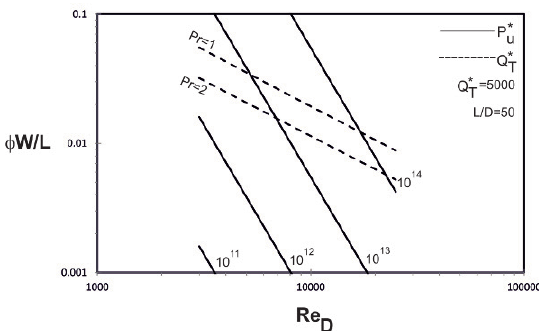
Figure 16. Influence of the Prandtl number on the variation of group with the Reynolds number (turbulent regime and constant heat-flux boundary)